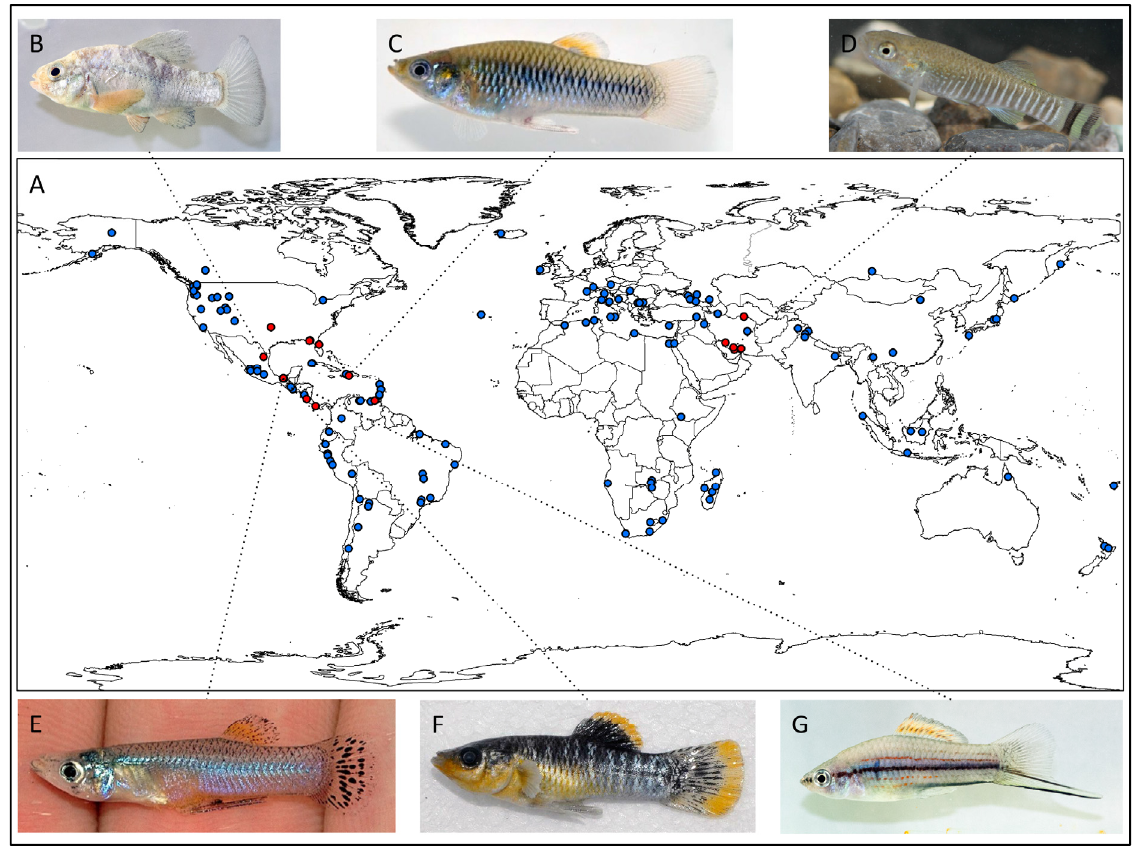
Figure 1. ( A ) Political map of the world indicating the locations of H dots). Red dots represent sulphide springs with records of fish. Locality information